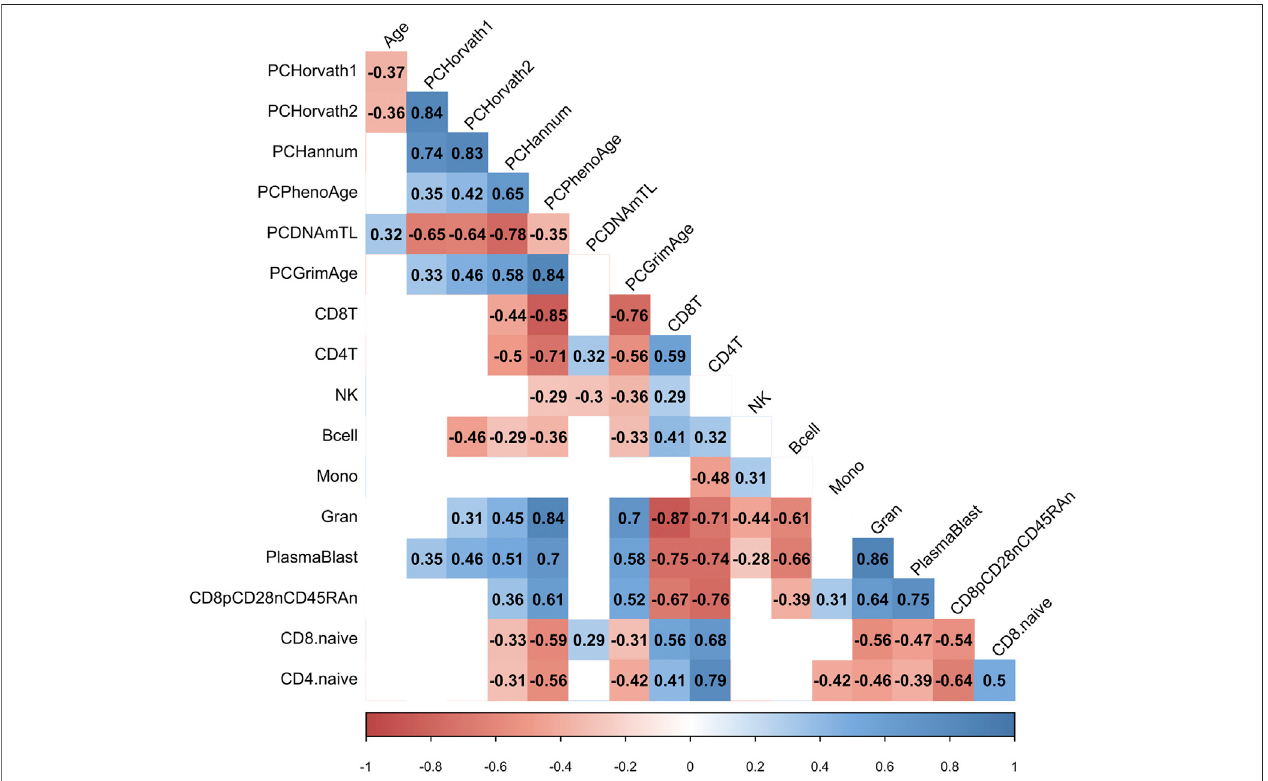
FIGURE8| mRNAvaccine-relatedepigeneticclockchangesassociatewithimmunecelltypechanges.Correlogramplotoftimesinceseconddose,thechangein PC-based epigenetic clocks pre- vs. post-COVID-19, and the change in inferred immune cell type following COVID-19. Signi fi cant correlations displayed as solid box and the Spearman ’ s rank correlation coef fi cient